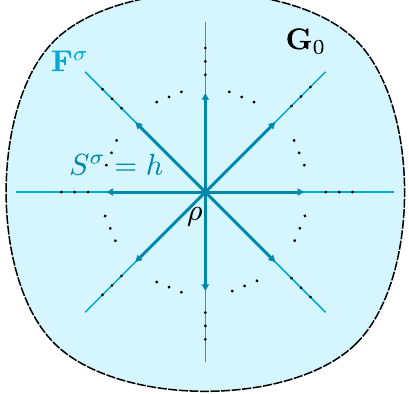
FIG. 4. For any h ∈ B , one can associate with it an exponential family (a straight line in the density-operator space) that passes through ρ . Since G 0 contains arbitrary density operators, every line must be contained in G 0 . It follows that each line is a parametric submodel for G 0 , and each h should be put in the tangent set. The dots represent the fact that the proof involves lines in all directions and, on each line, scores with all possible